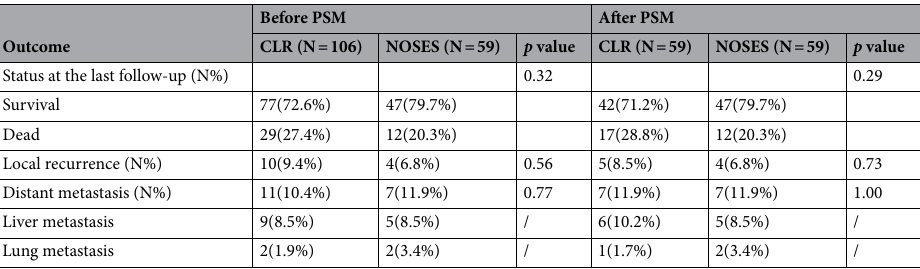
Table 5. Comparison of the long-term outcomes of the two